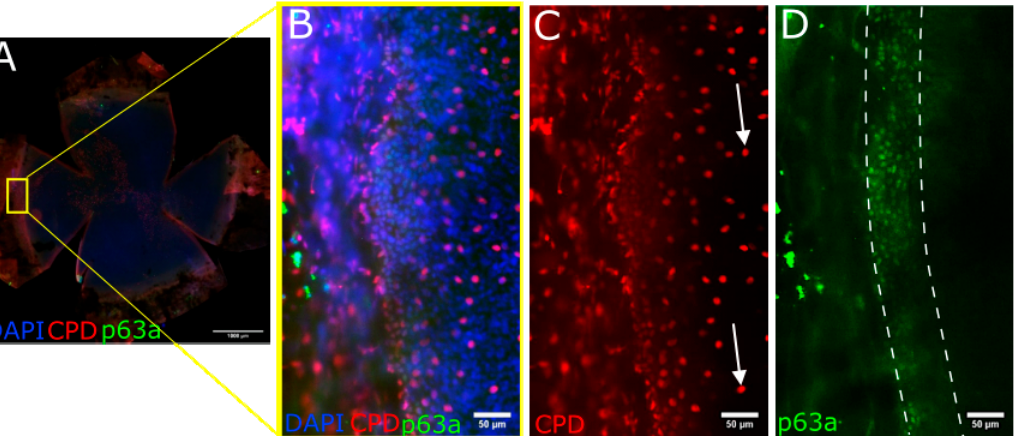
Figure 7. Images illustrating CPD induction in control mice following UVB exposure. CPDs stained with Alexa555 (( A – C ) shown here in red) and stem cell marker p63a stained with Alexa488 (( A , B , D ) shown here in green). Cells positive for CPDs outside the limbus are indicated by arrows in ( C ). Images were taken after 1 J/cm 2 UVB. CPD immunofluorescence was particularly concentrated in limbal regions, although not brighter.